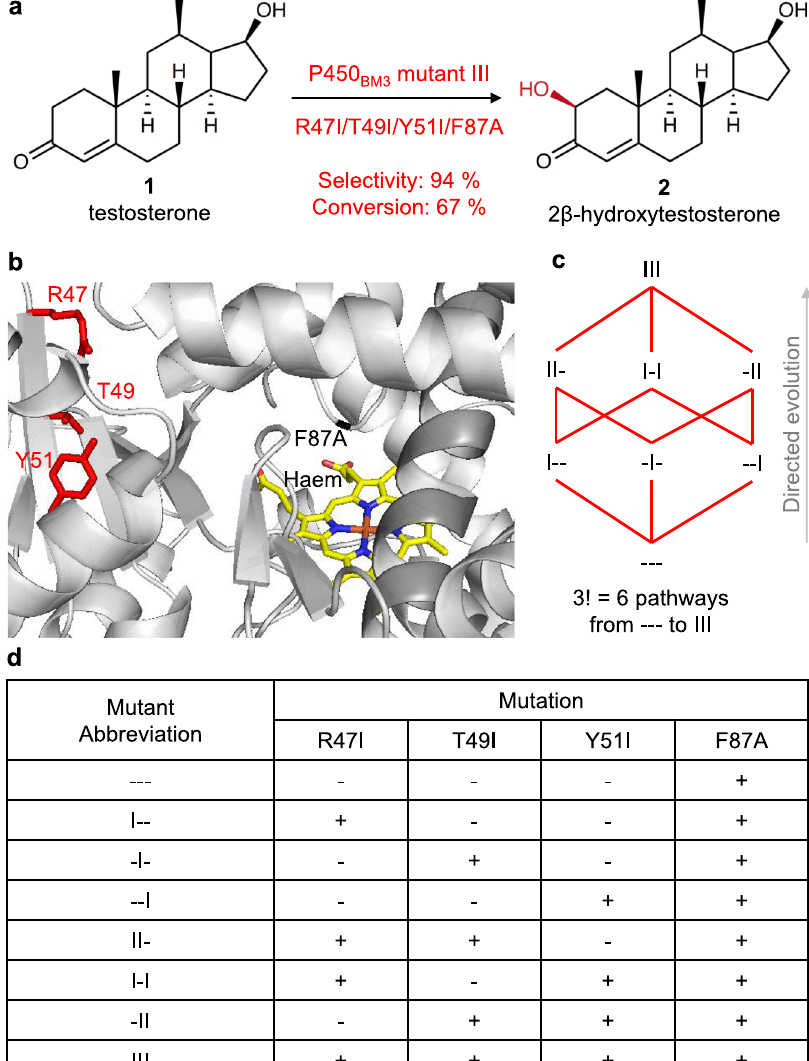
Fig. 1 Model system based on P450 BM3 as biocatalyst for the selective oxidation of a steroidal substrate. a Testosterone ( 1 ) is selectively hydroxylated at position 2 β ( 2 ) by mutant III (R47I/T49I/Y51I/F87A). b Active site of parent enzyme showing F87A mutation (black) above the haem (yellow) as well as WT resides R47, T49 and Y51 (red). The distances between the α -C atoms of the following pairs of residues are (Å): R47-T49 (7.0), R47-Y51 (13.4), T49-Y51 (7.0). Image and atom distances calculations obtained with PyMol Molecular Graphics System, V. 1.5.0.4 (Schrödinger, LLC). An interactive fi gure of parental variant --- docked with 1 was created with Michelanglo 68 (https://michelanglo.sgc.ox.ac.uk/r/p450) highlighting the mutated residues and secondary structures discussed in this work. c The 6 possible evolutionary trajectories between parental mutant F87A (---) and “ triple ” mutant III involve three “ single ” mutants I-- (R47I/F87A), -I- (T49I/F87A) and --I (Y51I/F87A) as well as three “ double ” mutants II- (R47I/T49I/F87A), I-I (R47IY51I/ F87A) and -II (T49I/Y51I/F87A). d Mutant abbreviations. The signs − and + indicate that the respective mutation is absent and present,